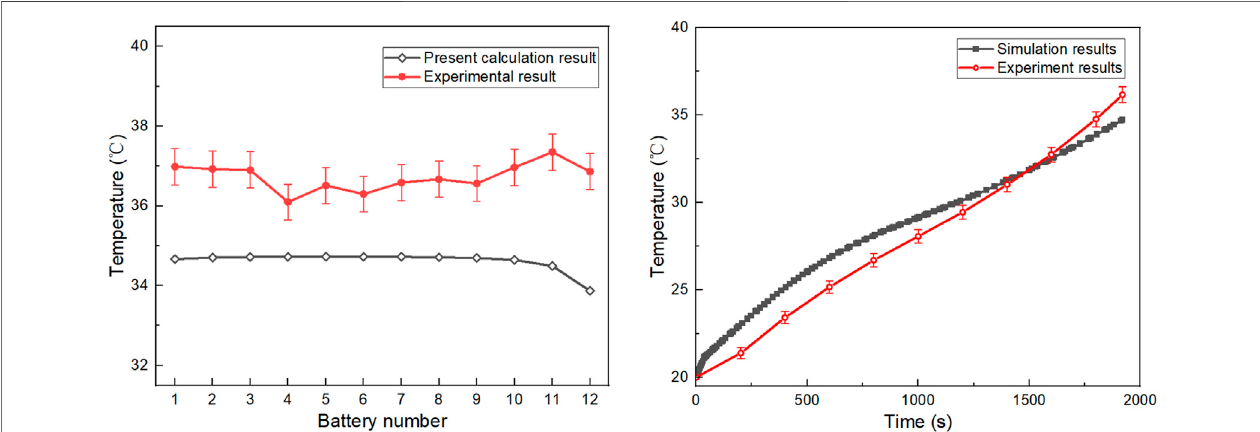
FIGURE 5 | (A) Temperature distribution of 12 battery cells at the end of discharge. (B) Temperature development of the battery cell in the middle of module in discharging process.